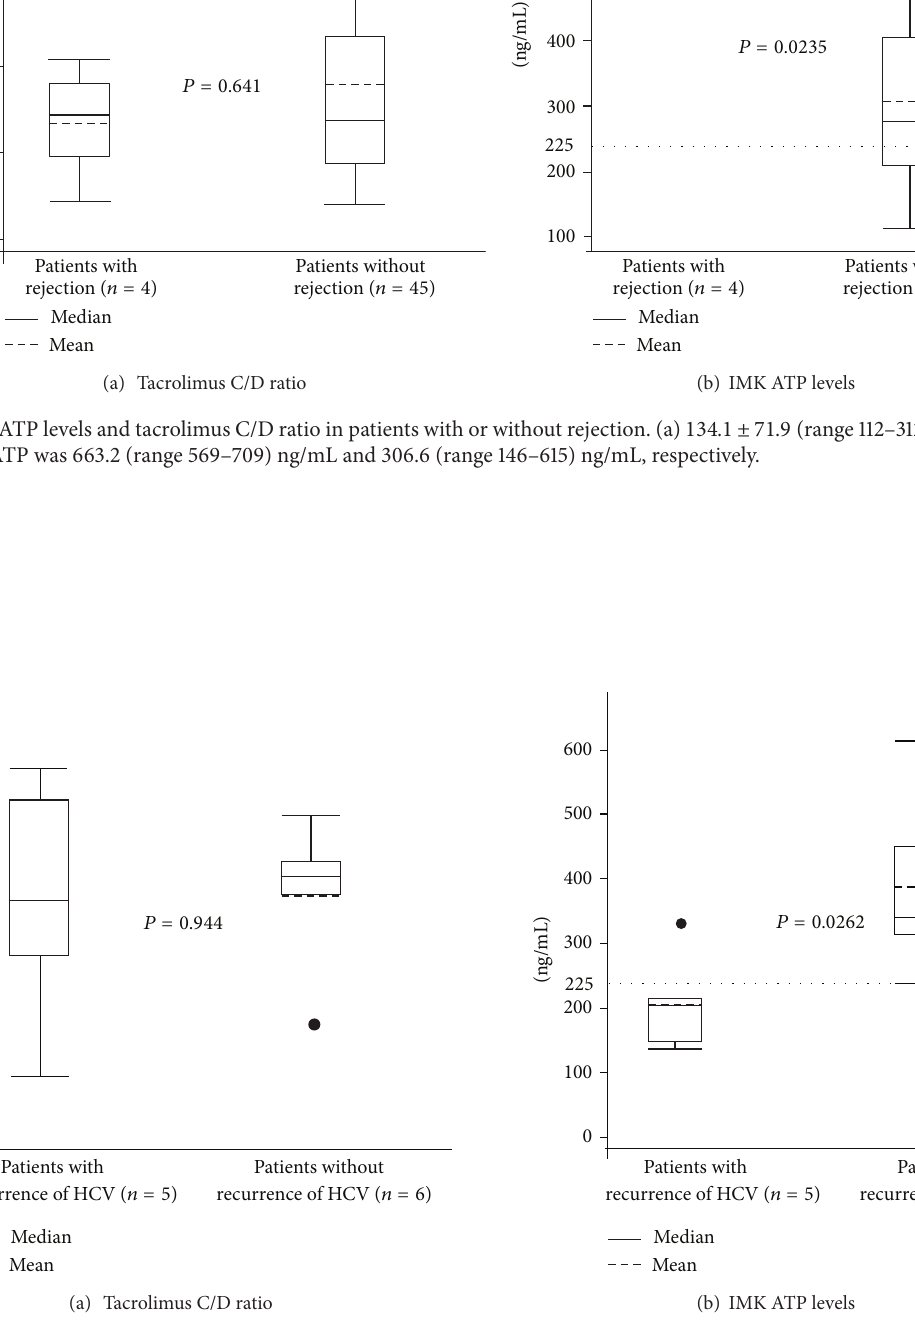
Figure 4: IMK ATP levels and tacrolimus C/D ratio in patients with hepatitis C. (a) 166.4 ± 94.2 (range 112–312) ng/mL and 170.4 ± 56.8 . (b) The ATP was 215.0 (range 141–322) ng/mL and 398.4 (range 238–615) ng/mL,